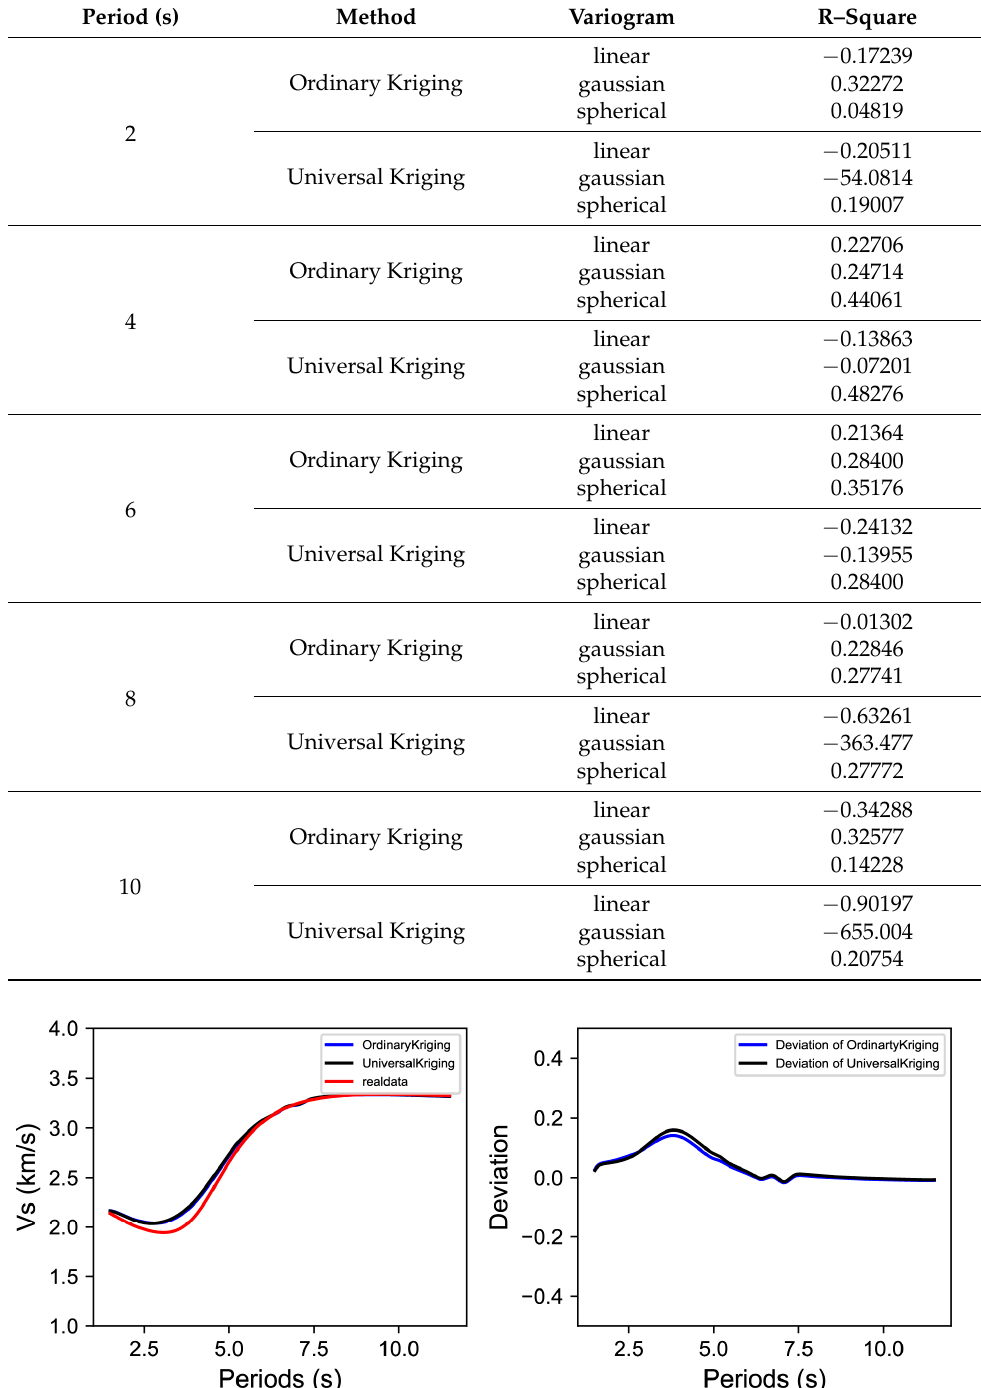
Table A1. R–square of each variogram with different kriging in each period.